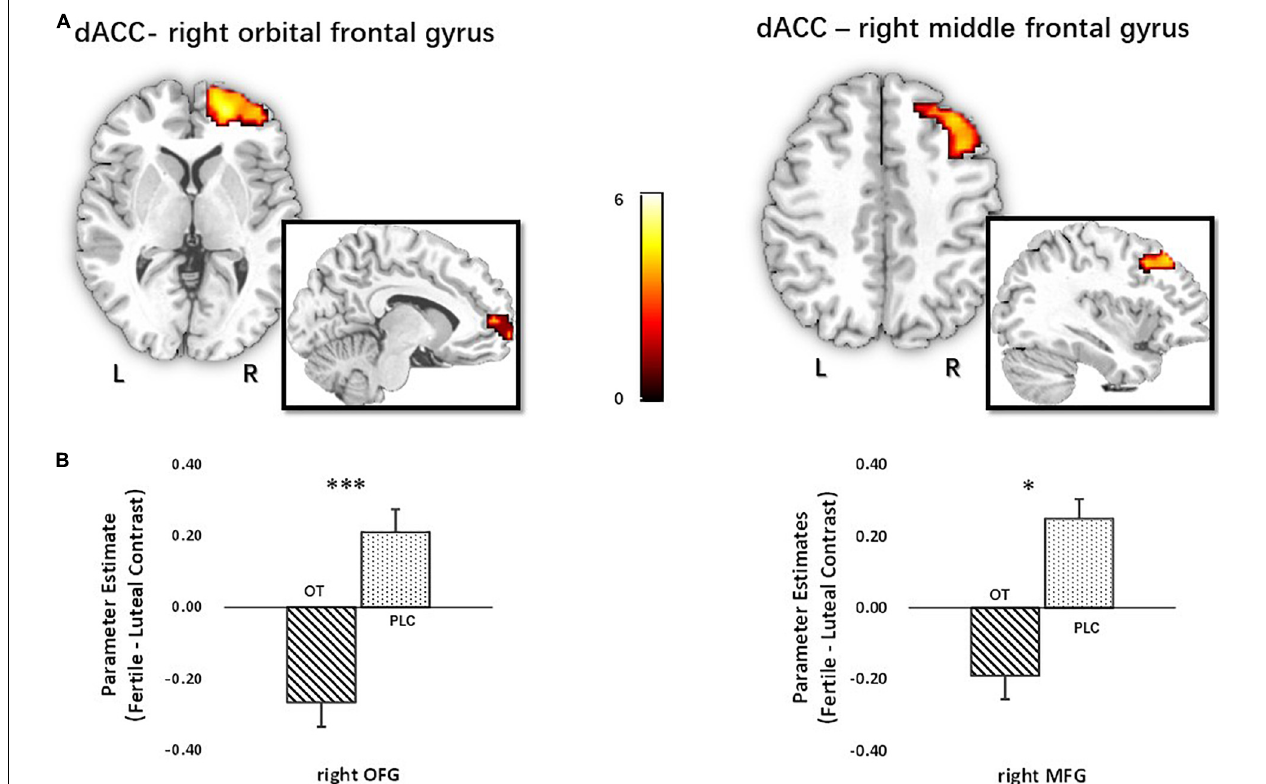
FIGURE 6 | Functional connectivity analysis with dACC seed for novel metaphorical compliments based on cycle contrasts (fertile > luteal) ( n = 62). (A) The t map of functional connectivity of dACC seed with right OFG ( x = 21, y = 53, z = –1; t 60 = 5.40) and right MFG ( x = 39, y = 29, z = 44; t 60 = 4.32). Parameter estimates were extracted using the peak MNI coordinates. (B) Extraction based on the fertile > luteal contrast revealed that oxytocin significantly decreased the functional connectivity of dACC seed with right OFG and right MFG relative to placebo, ∗ p < 0.05, ∗∗∗ p < 0.001, two-tailed t- test. Bars indicate M ± SE. L, left; R, right; dACC, dorsal anterior cingulate cortex; OFG, orbital frontal gyrus; MFG, middle frontal